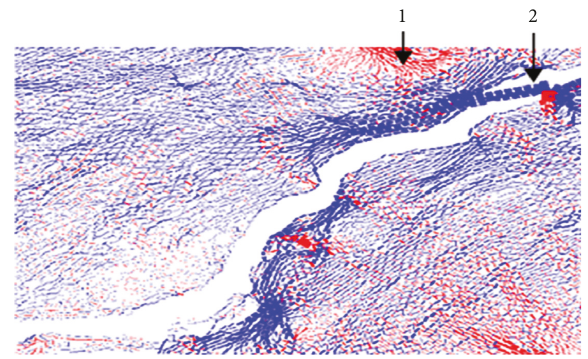
Figure 17: Force chain diagram of crack location in the lower